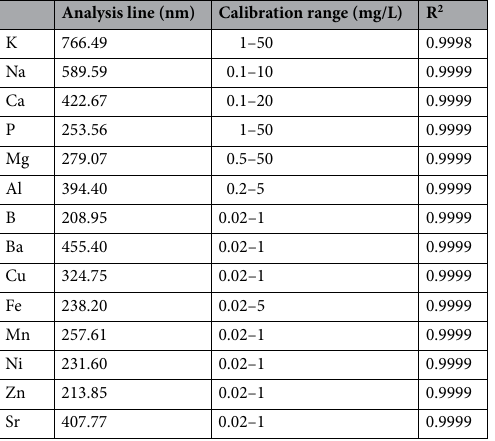
Table 3. Summary of calibration parameters and analytical